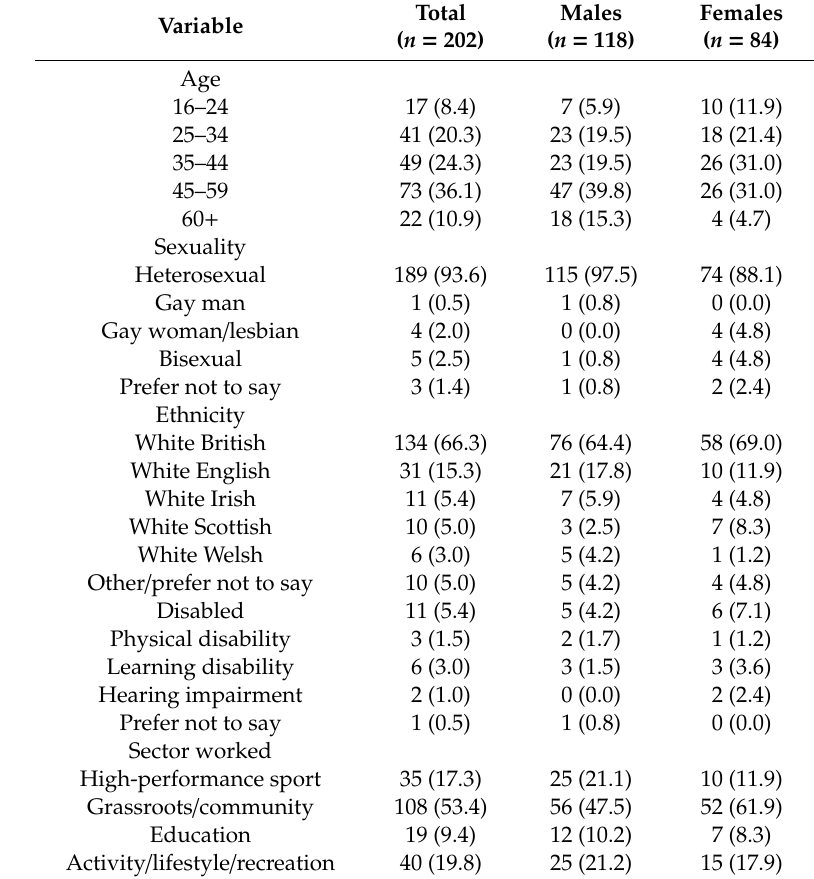
Table 1. Demographic characteristics of sample ( n and %).